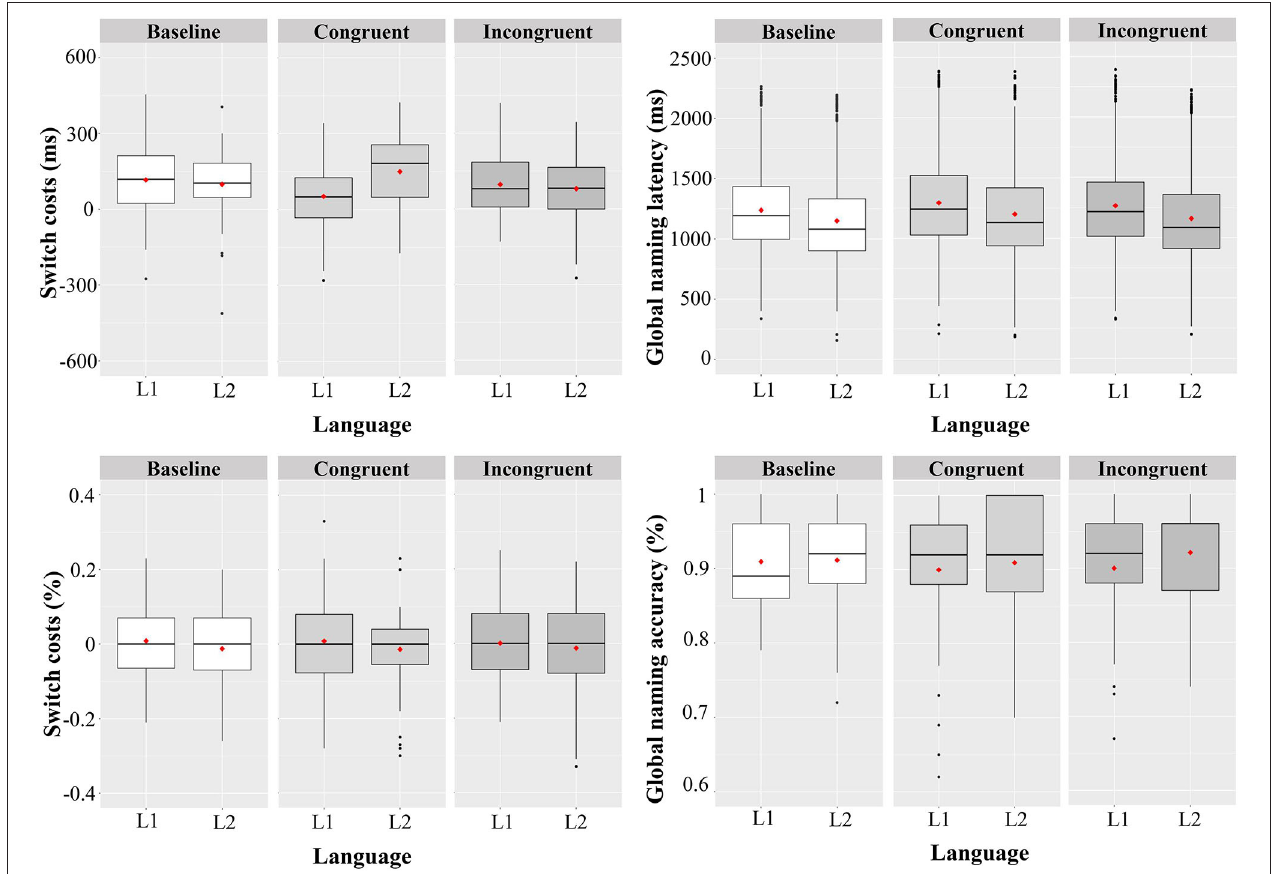
FIGURE 3 | Boxplots showing the language switch cost (left) and reversed dominant effect (right) in RTs (top panel) and accuracy (below panel) across cultural contexts. The boxplot shows the interquartile range with the black dots representing the outliers falling outside the 1.5*interquartile range. The median is indicated by the horizontal black line and the centers of the red quadrangle indicated the